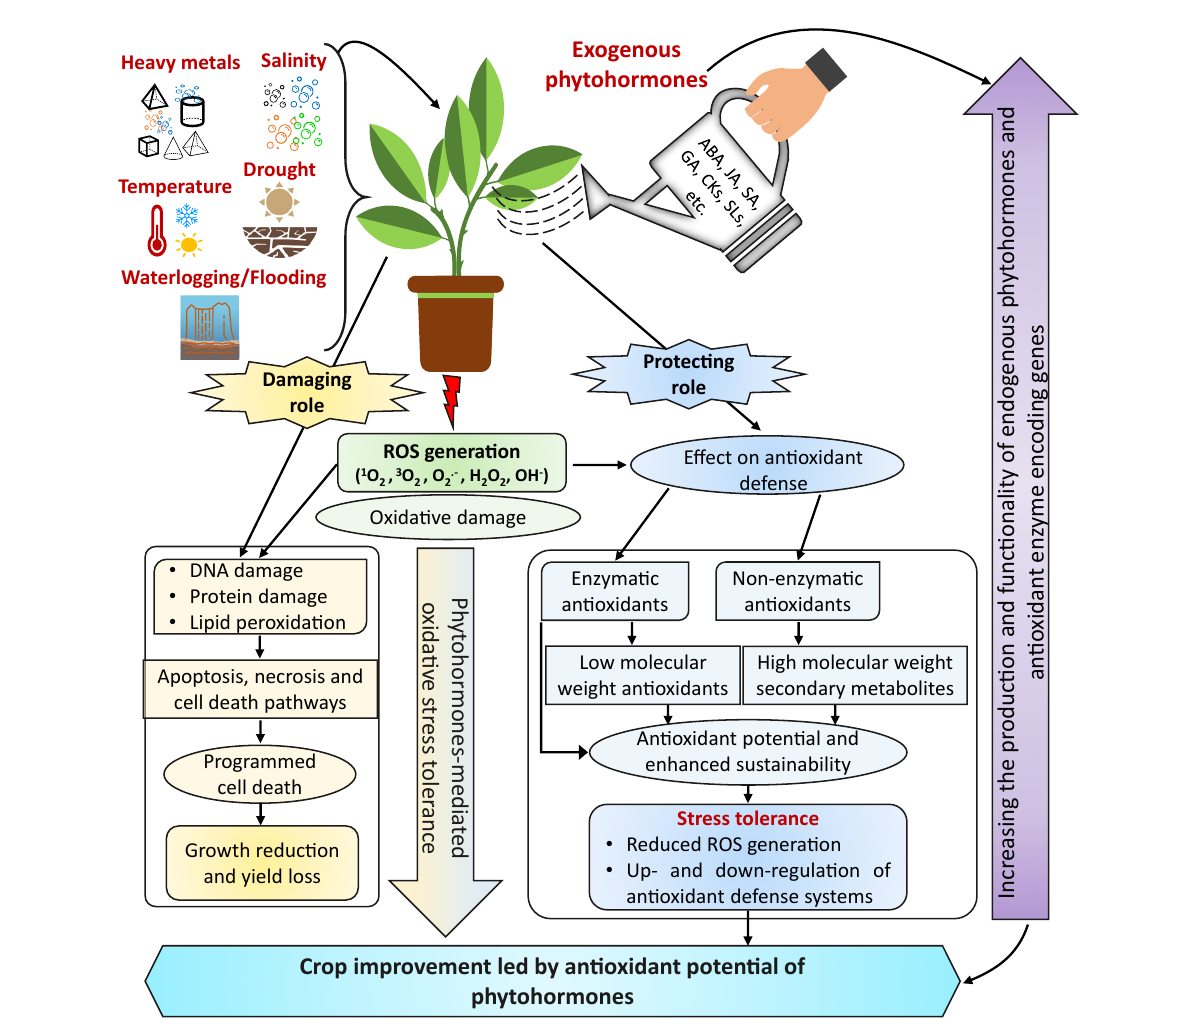
FIGURE4 The proposed model demonstrates the state-of-the-art potential of a phytohormone-mediated antioxidant defense system under abiotic stress. Notably, phytohormones decrease the damaging effect of oxidative stress induced by abiotic stress because they act as secondary messengers to initiate antioxidants and can thus scavenge ROS in stressed plants. Interestingly, exogenous phytohormone application can reduce ROS overproduction, enhancing the activities of several antioxidant defense systems and stress tolerance; it varies with the type of stress, plant type, and duration. However, ROS overproduction can significantly reduce growth and yield under stressful conditions. In addition, exogenous phytohormones can increase the production and functionality of endogenous hormones and transcript levels of antioxidant enzyme-encoding genes, e.g., SOD, CAT, and POD . The optimal dose and growth stage for phytohormone application needs further investigation—modified from Raza et al. (2021c) with permission from the publisher (Springer